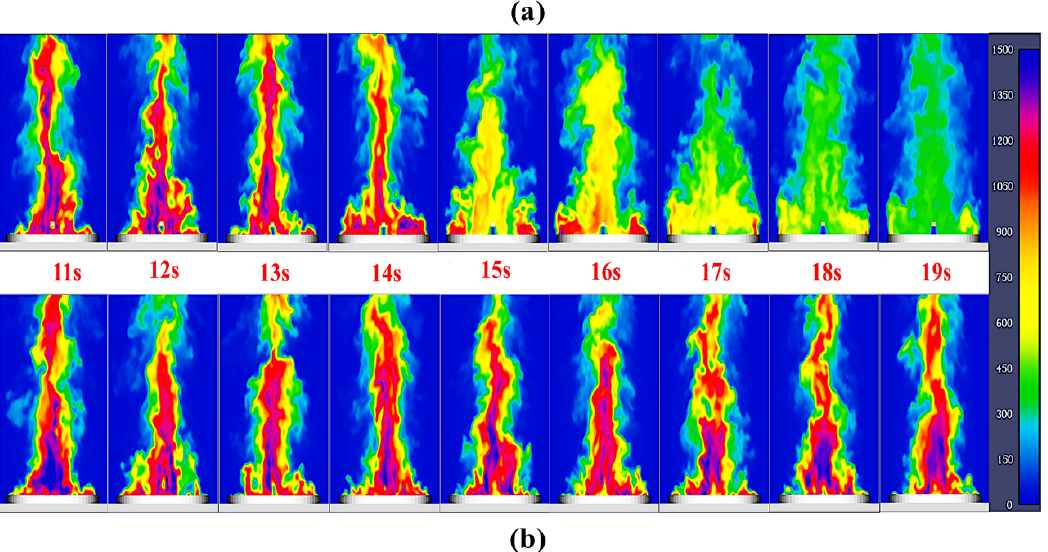
Figure12. Thermalvariationsduringthewholeprocessobtainedbythetwo-dimensional(2D)temperature Figure 12. Thermal variations during the whole process obtained by the two-dimensional (2D) plane. ( a ) Mixture suppression, ( b ) water mist temperature plane. ( a ) Mixture suppression, ( b ) water mist suppression.